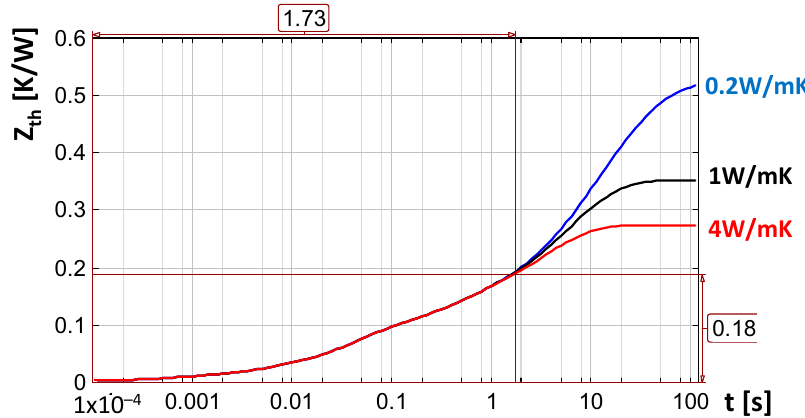
Figure 7. Z th curves at thermal conductivities of the TIM at 0.2 W / mK, 1 W / mK, and 4 W / mK.